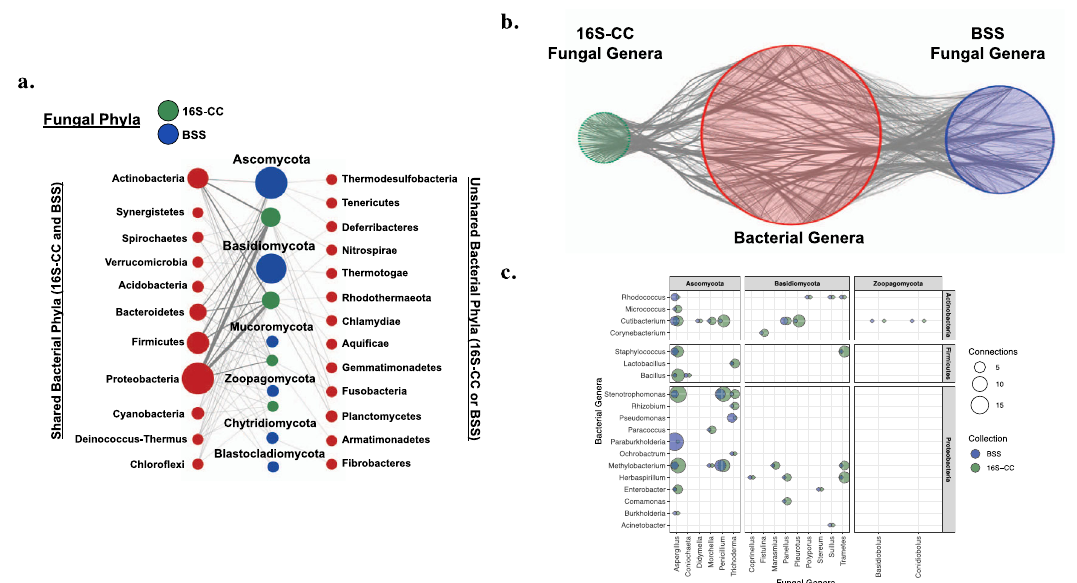
Fig. 6 Phylum and genus level bacterial – fungal associations identi fi ed in fungal culture collections and genome sequencing projects. a Tripartite network showing associations (gray edges) between bacterial phyla (red) and fungal phyla from either the 16S-CC (green) or BSS (blue) screen. Bacterial phyla that were identi fi ed in both screens are shown on the left, while phyla only identi fi ed in one screen are shown on the right. Nodes are sized by the number of genera represented in each phylum and edges are weighted by the number of distinct associations among bacterial and fungal genera. b Network of associations (gray edges) between bacterial genera (red nodes) and fungal genera from either the 16S-CC screen (green nodes) or the BSS screen (blue nodes) generated using Cytoscape, which demonstrates the complexity of the overall network of potential associations detected across both screens at the genus level. c Genus-level bacterial – fungal associations identi fi ed in both the 16S-CC and BSS screen. The size of each circle corresponds to the total number of genera detected in each